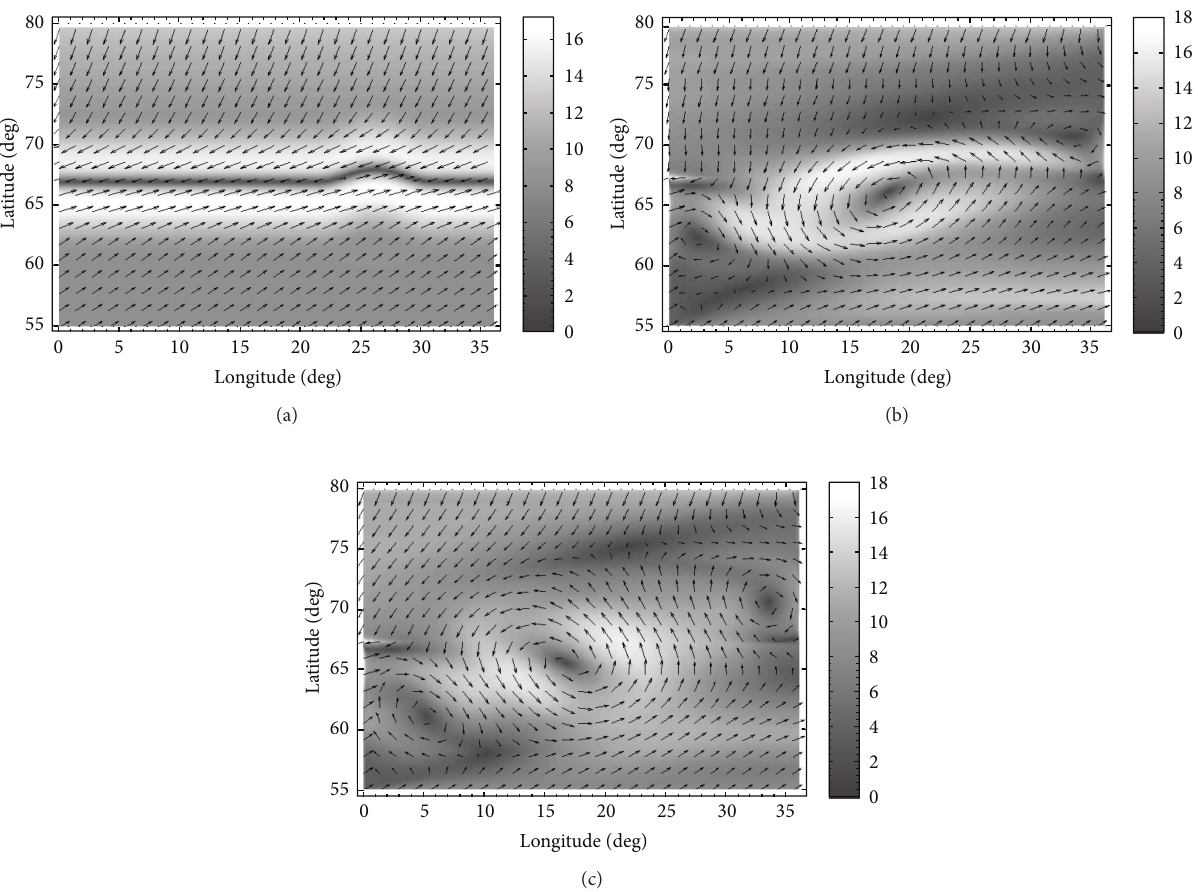
Figure 4: The same as in Figure 3, but obtained for the fourth case when, at the initial moment, the modules of the zonal wind velocities at more northern latitudes relatively to the centerline of the arctic front are less than those at more southern latitudes relatively to it. The degree of shadowing of the figures indicates the module of the velocity in